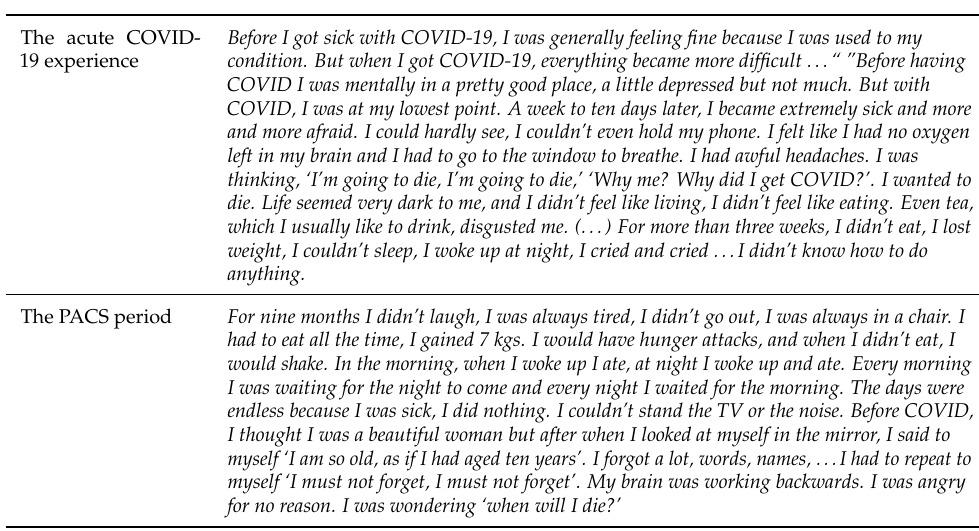
Table 3. Acute COVID-19 and PACS experience of patient MGA001 interviewed by GK. The patient is a Kurdish speaker expressing herself in French. The verbatim, translated in English, has been slightly improved.